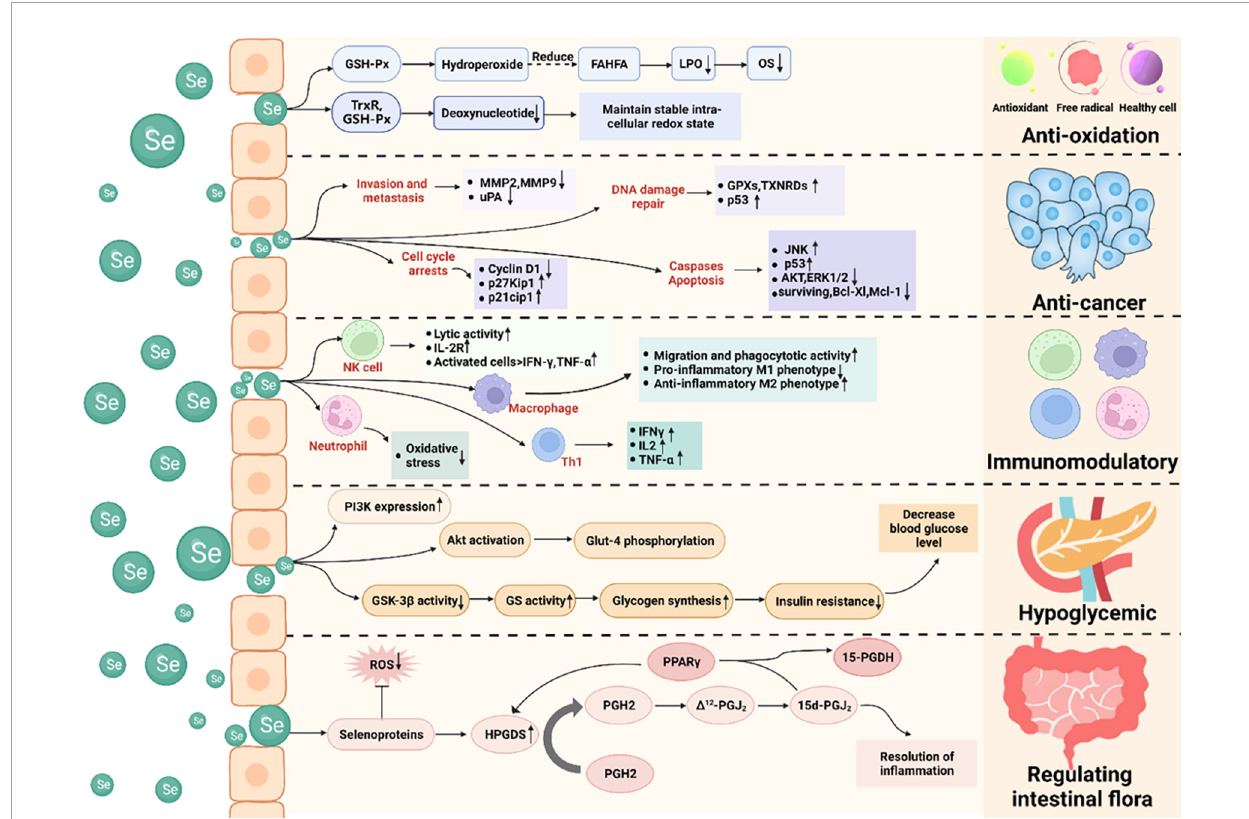
FIGURE2 Health-promoting effects of selenium and its mechanisms of action. Selenium possesses anti-oxidant, anti-cancer, immunomodulatory, hypoglycemic, and intestinal microbiota-regulating properties. It acts as an anti-oxidant by lowering oxidative stress and deoxynucleotide levels. It functions as an anti-cancer agent by inducing apoptosis and cell-cycle arrest, preventing tumor cell invasion and metastasis, and promoting DNA damage repair. It exerts immunomodulatory effects by affecting non-specific immunity (e.g., macrophages and neutrophils) and specific immunity (e.g., T and B lymphocytes). It exerts hypoglycemic action by regulating the IRS-PI3K-Akt signaling pathway. It regulates the intestinal microbiota by regulating